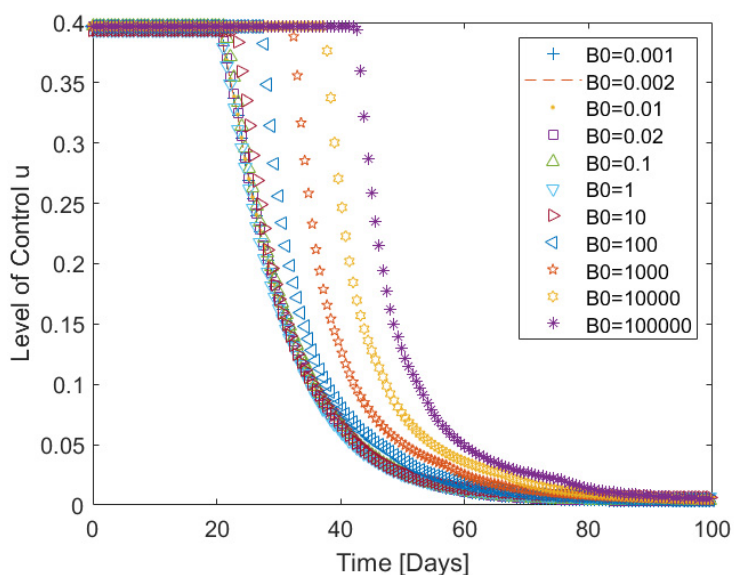
B weightings of Equation (15). 0